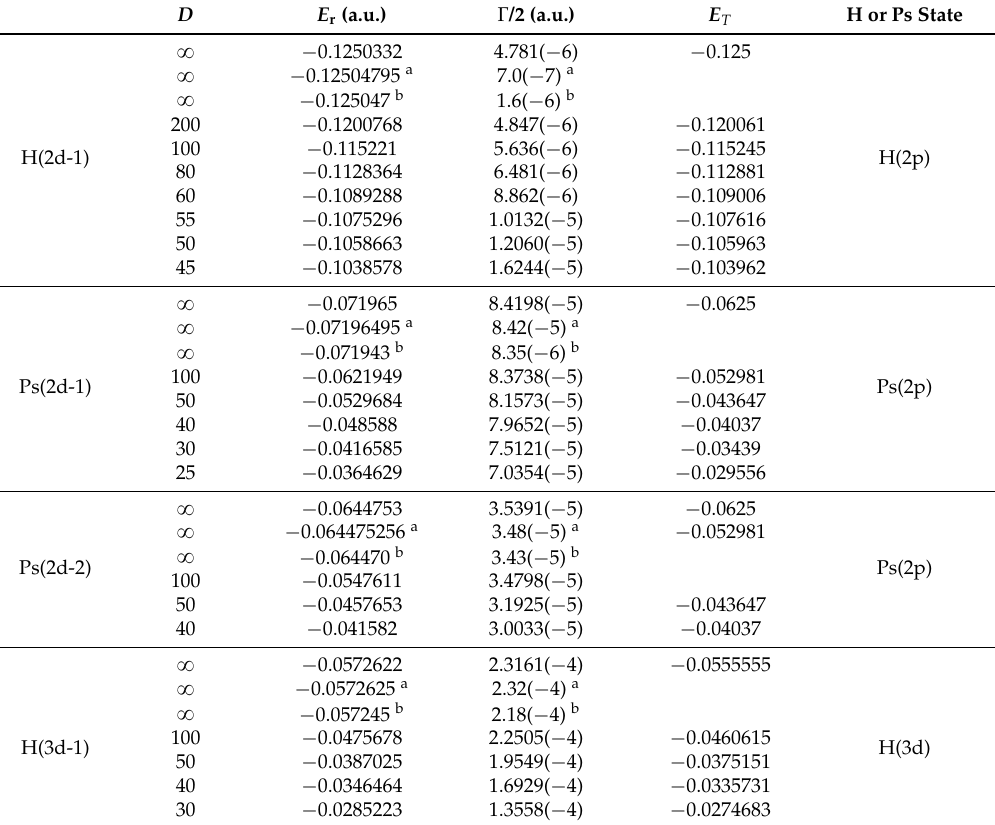
Table 1. D -wave resonances with natural parity in positron-hydrogen scattering with various Debye lengths D . The threshold energies E T are associated with the excited nl states of the parent (H or Ps) atom. The notation A( ´ B) denotes A ˆ 10 ´ B . Units are in a.u. D E r